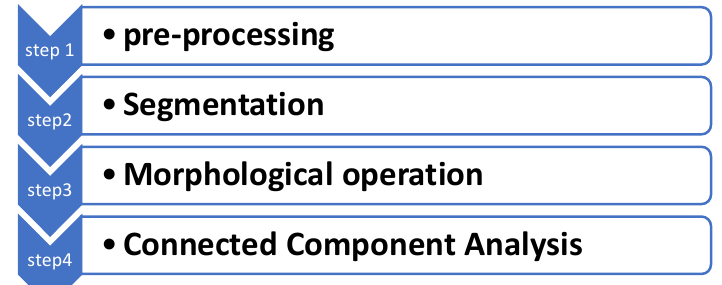
Figure 1. Methodology Flowchart.